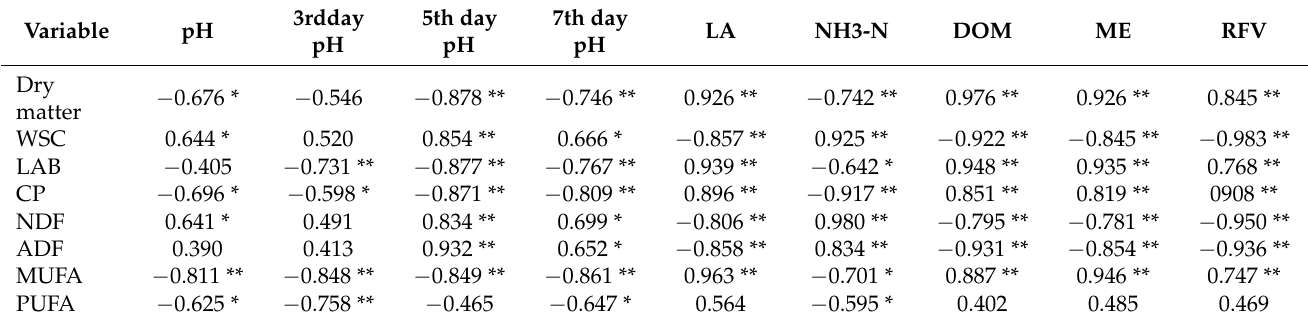
Table 10. Pearson correlations between main quality criteria in